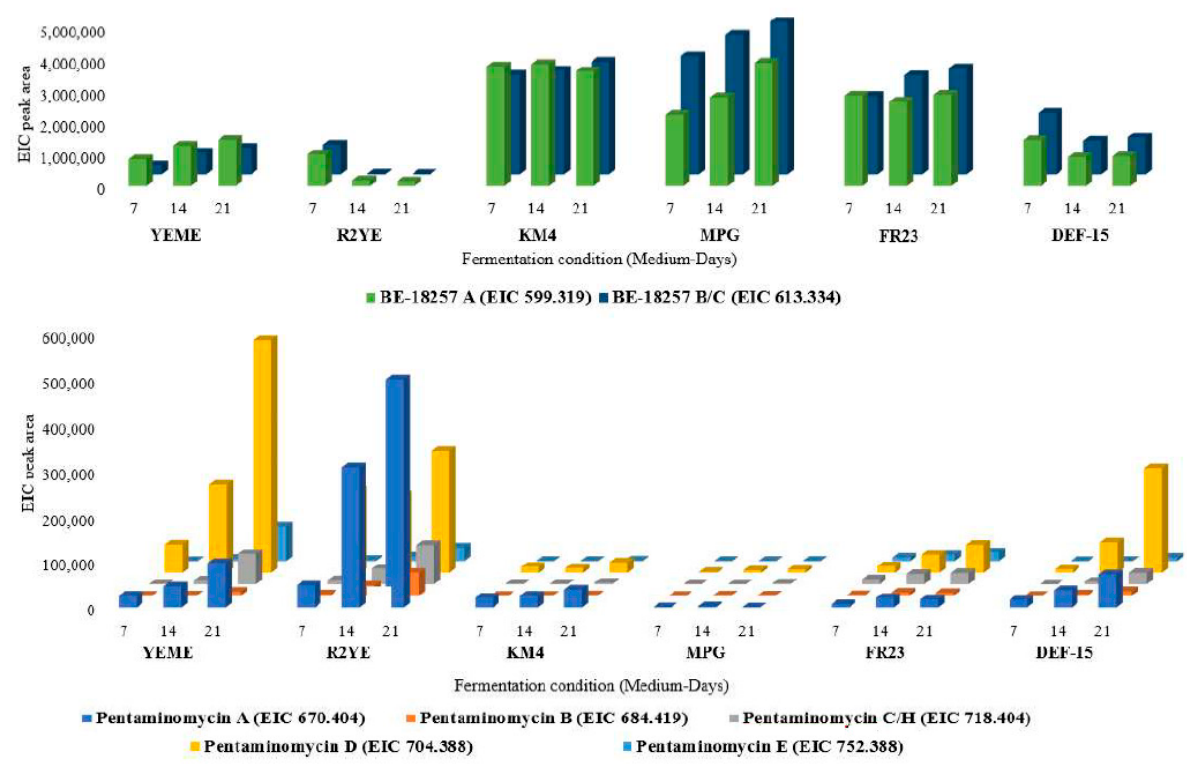
Figure 3. Production of BE-18257 antibiotics (top) and pentaminomycins A–E and H (bottom) by strain S. cacaoi CA-170360 in six different media at three different times (7, 14 and 21 days). The average extracted ion chromatogram (EIC) peak area from triplicate culture extracts of the strain CA-170360 is